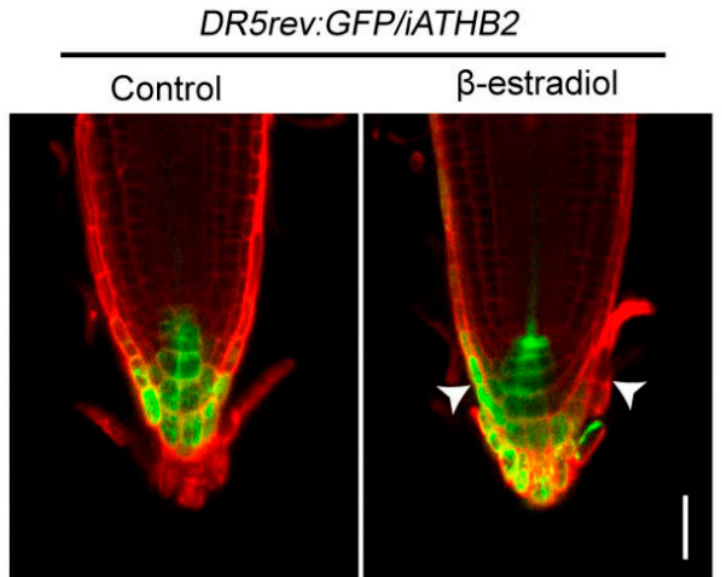
Figure 4. Asymmetric auxin response was observed in the root tips of iATHB2 plants. The spatial expression pattern of the DR5rev:GFP auxin responsive reporter in the root tips of 6-day-old DR5rev:GFP / iATHB2 plants grown on the medium with or without 10 µ M β -estradiol. The images are representative of three independent experiments. Roots were stained with propidium iodide (red). Arrowheads indicate the asymmetric auxin response in the root tips. Scale bars = 50 µ m.